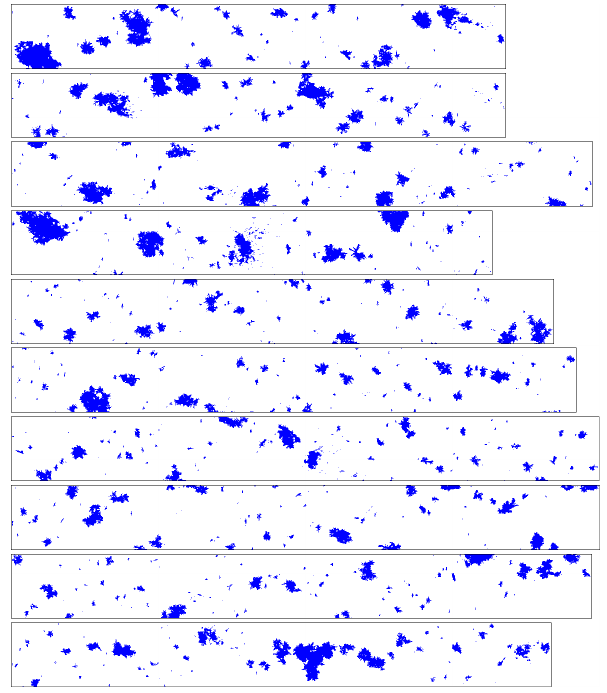
Figure 9. HVPS sample images of hydrometeor shadows on 13 De- cember 2015 at 16:18UTC. The images correspond to the trajectory within the DOW sector scan starting at 16:17UTC. The height of each panel represents 19.2mm.